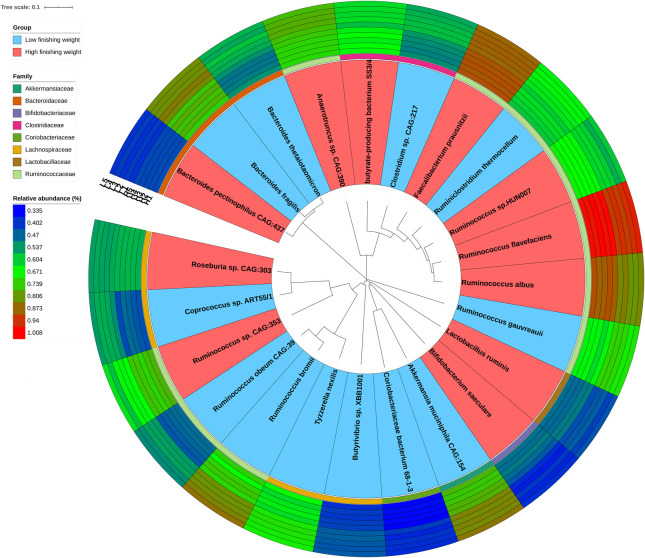
The phylogenetic relationships and abundances of metagenomic species enriched in high and low finishing weight rabbits. The phylogenetic tree of species is shown as the innermost layers. Labels with red and blue color represent high and low finishing weight groups, respectively. The different color strips in the third layer correspond to different families as indicated by the color code on the left. The outermost layers depict the relative abundances of differential species between high and low finishing weight individuals.